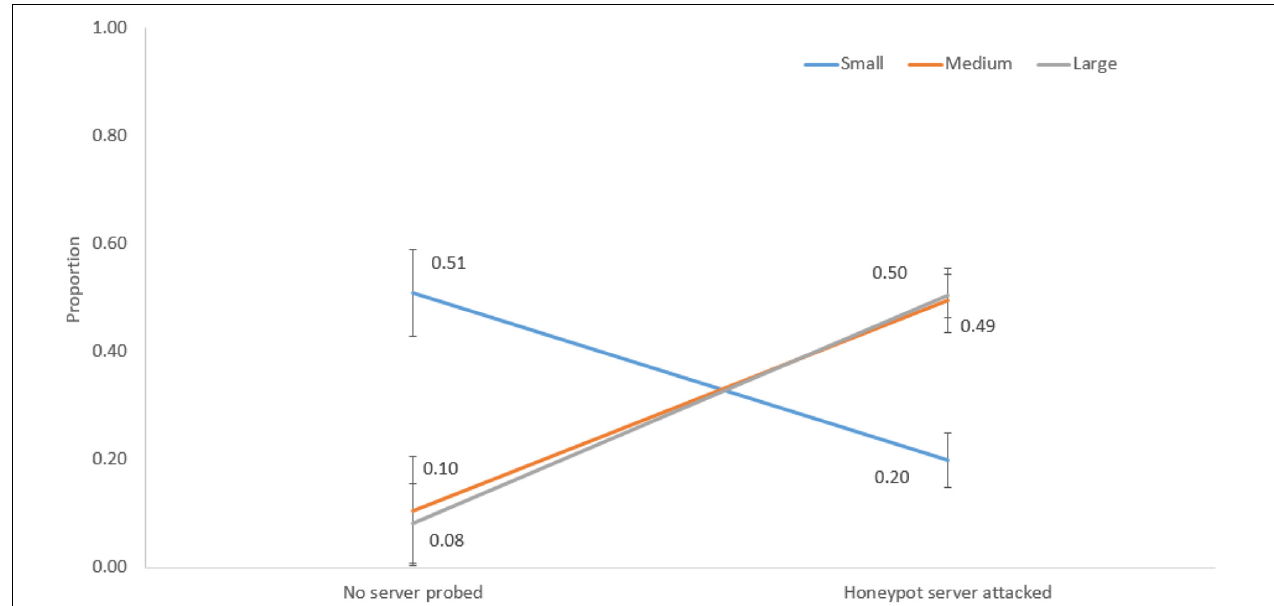
FIGURE 11 | The proportions of no server probed and honeypot server attacked decisions in different network